Question: What kind of plot is shown here?
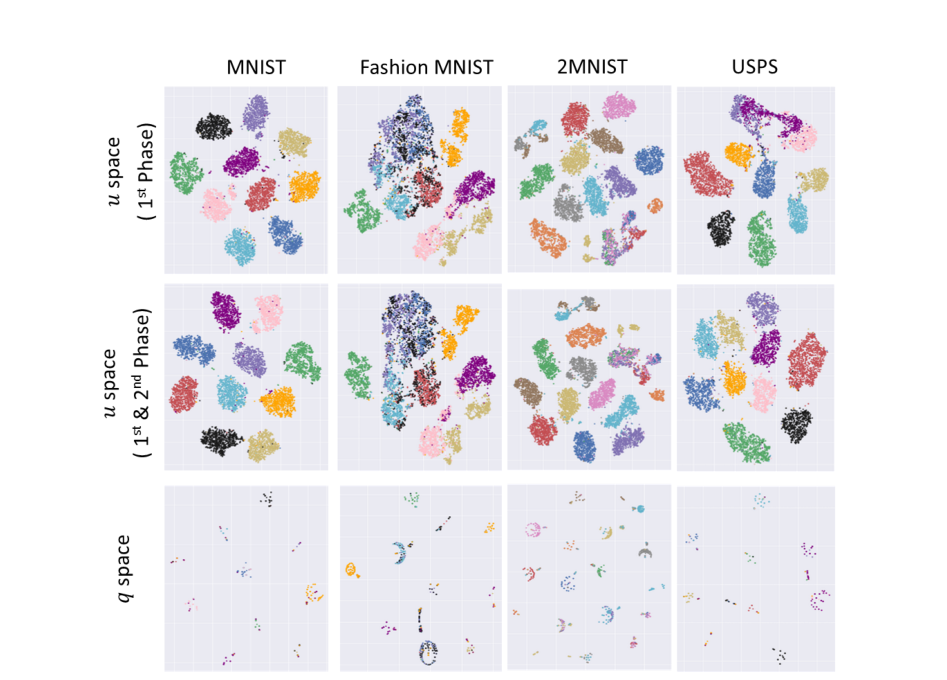
Answer: scatter